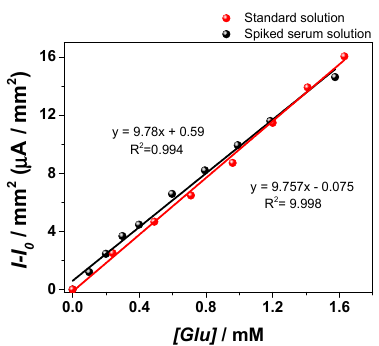
Figure 11. Calibration curve for the Cu/Nif on Cu electrode in the range of 0.24–1.63 mM Glu (red line) performed on standard solutions and on commercial human serum spiked with 0.1 M Glu (black line) (0.55 V, 0.1 s step potential, 1200 s analysis time).